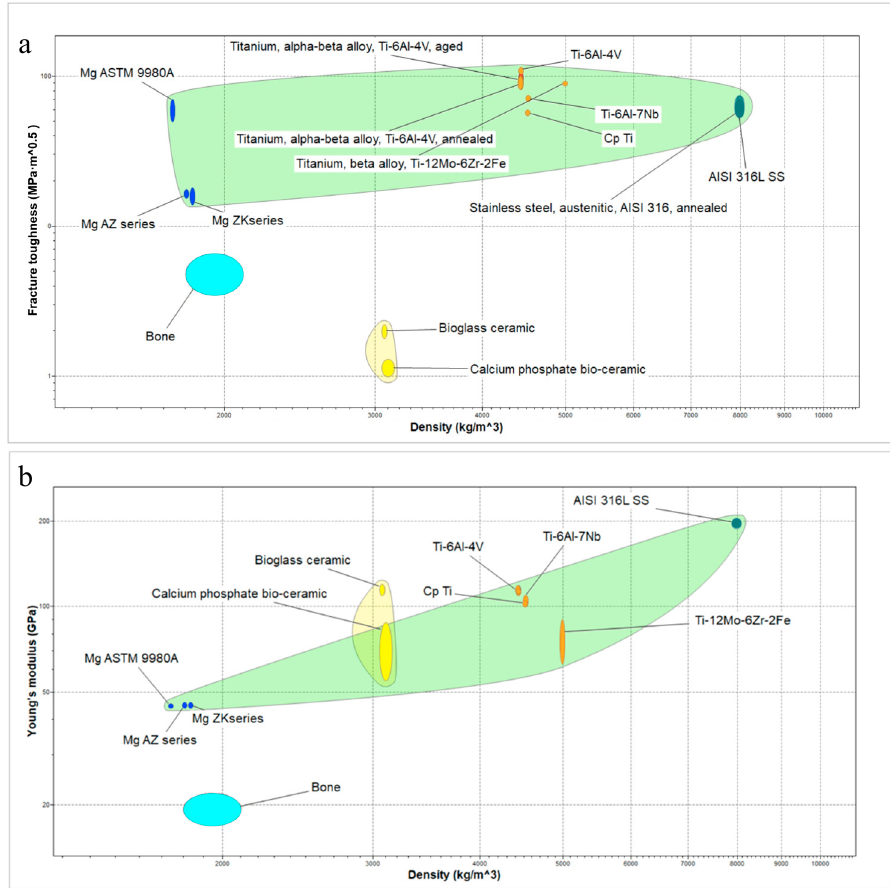
Figure 1. ( a ) Fracture toughness and density; ( b ) elastic modulus and density of bone, coating materials and most common metallic materials used in orthopedics and implant dentistry. Data elaborated using CES EduPack™ 2018.